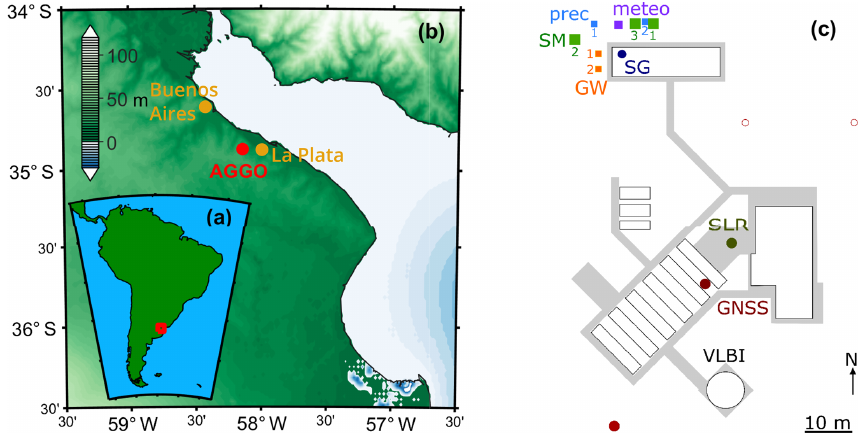
Figure 1. Location of the study site ( a, b , φ = 34 ◦ 52 (cid:48) 24 (cid:48)(cid:48) S, λ = 58 ◦ 8 (cid:48) 24 (cid:48)(cid:48) W). The local map ( c on the right) shows the approximate instrumentation position (in colour), buildings as of April 2017 (white), and pavements (grey) at the AGGO site. Precipitation gauges (prec) in blue, soil pits for soil moisture (SM) sensors in green, weather station (meteo) in purple, superconducting gravimeter (SG) in dark blue, Global Navigation Satellite System (GNSS) antennas in red, groundwater (GW) observation wells in orange, and satellite laser ranging (SLR) station in dark green. The map was created using Amante and Eakins (2009), Wessel and Smith (1996), and M_Map toolbox (http://eoas.ubc.ca/~rich/map.html, last access: 2 November